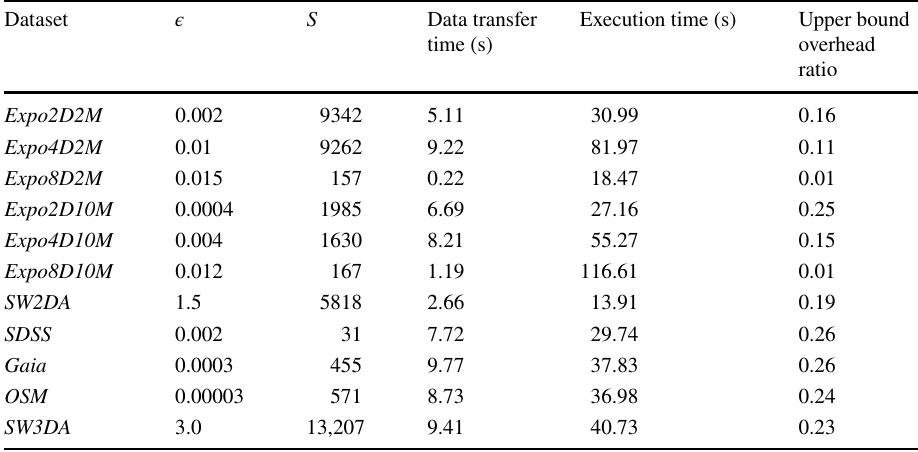
Table 5 Total time taken by data transfers between the CPU and the GPU, the total execution time of the algorithm, and the upper bound overhead ratio of the data transfers time to the execution time when using HEGJ oin -d